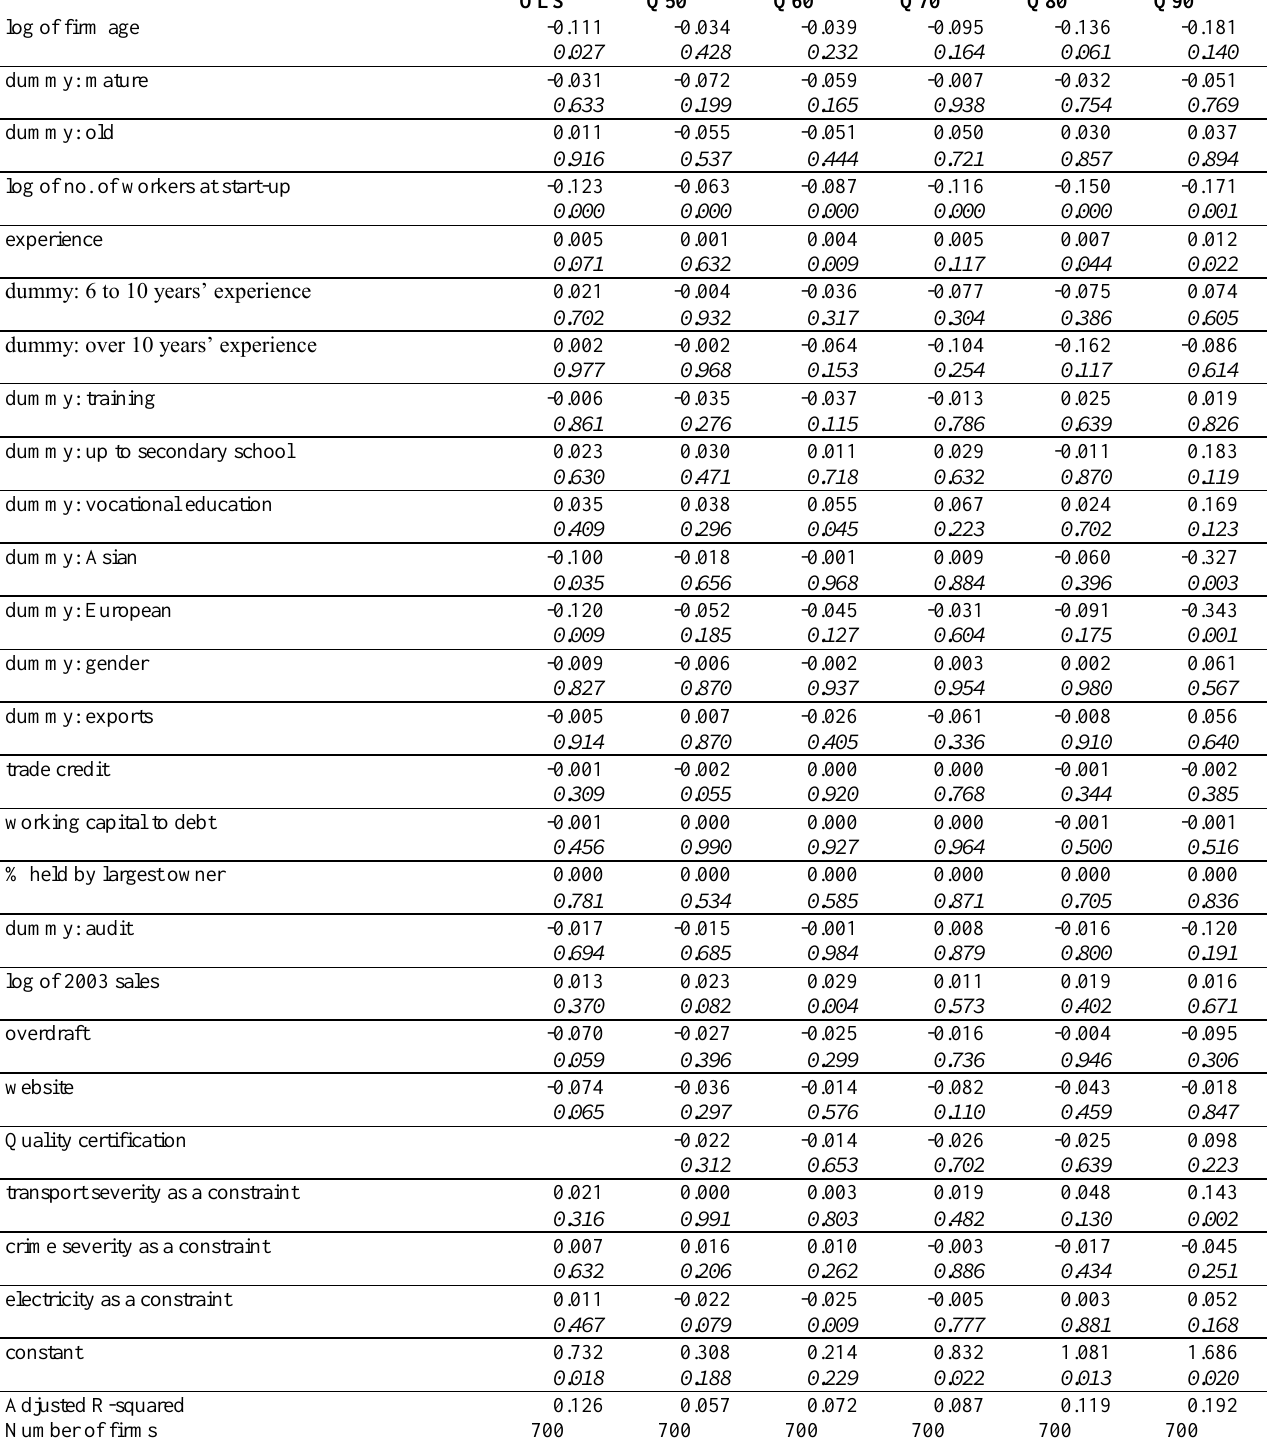
Table 4: Results of quantile